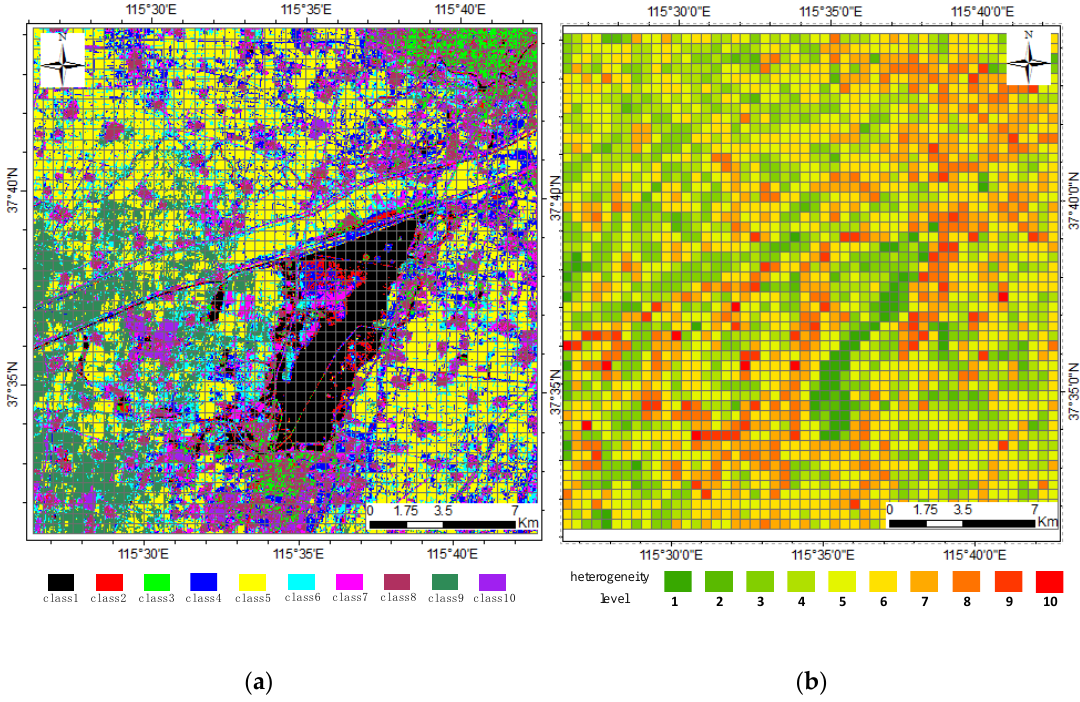
Figure 4. The distribution of different heterogeneity levels in the study area. ( a ) class types within a grid (MODIS pixel scale), ( b ) the heterogeneity levels of MODIS pixels.